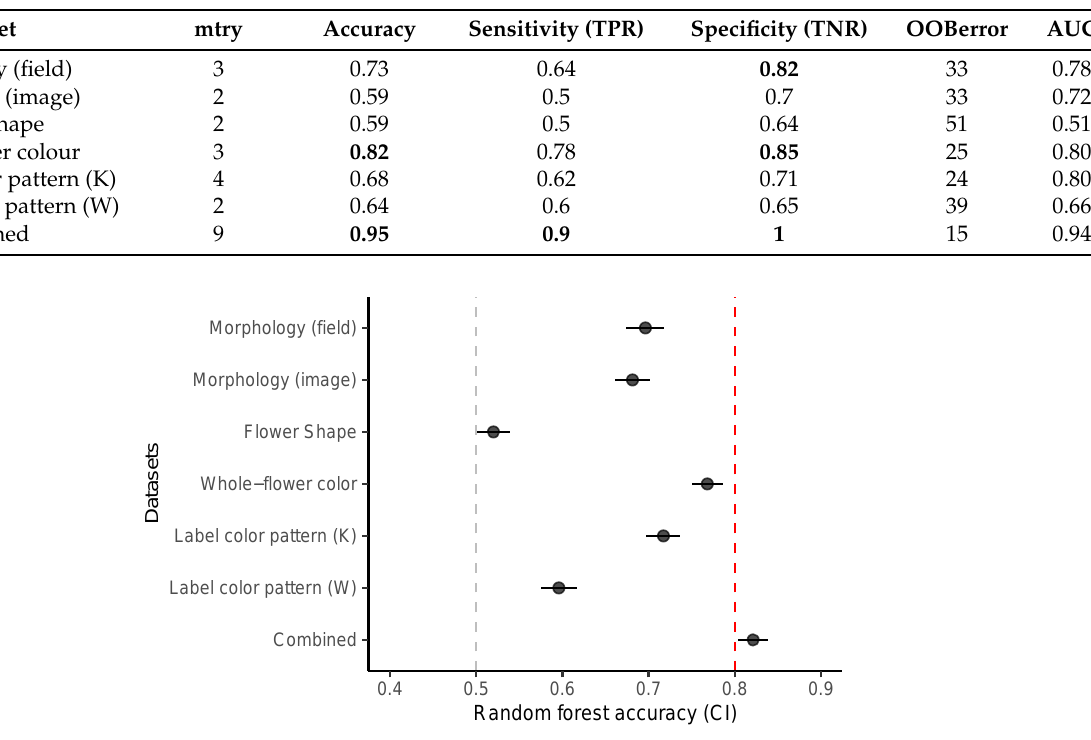
Figure 6. Accuracy (mean value, 95% CI) over 100 random forest models for each dataset. The best classifier (the “combined” one) achieved 100% specificity (i.e., the percentage of O. a. subsp. vitorica predicted correctly) and had 90% sensitivity (i.e., the